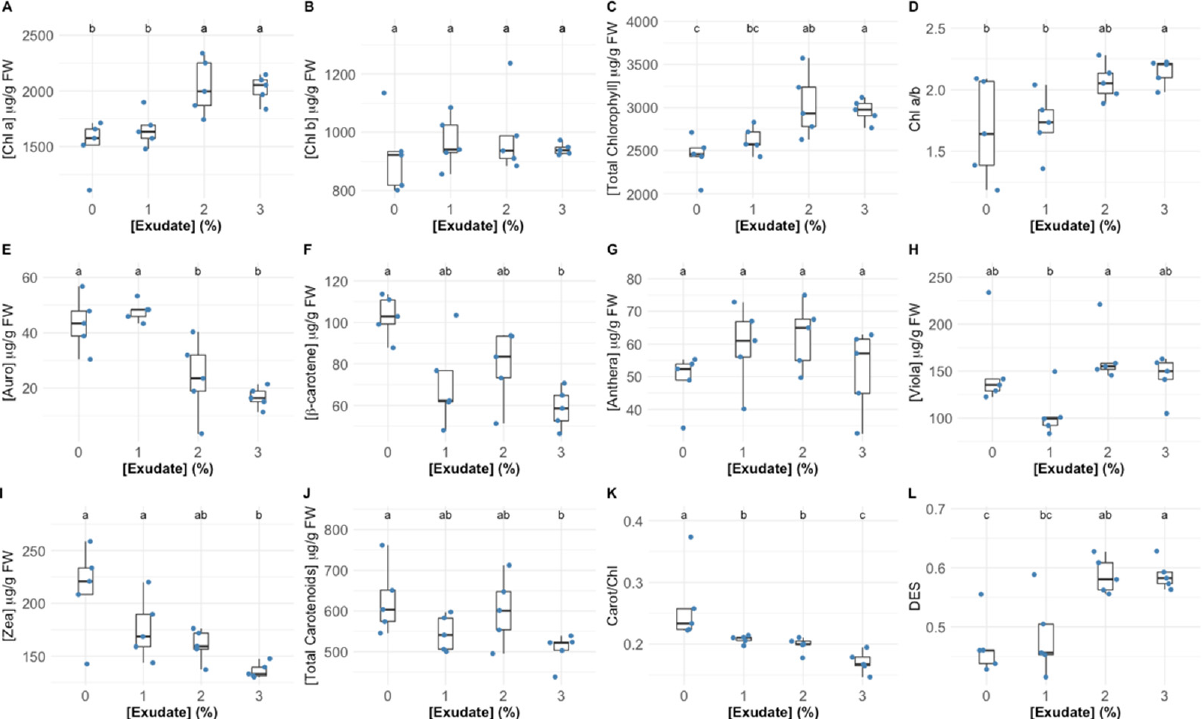
Figure 4. Thellungiella halophila pigment concentrations (Chl a—chlorophyll a ( A ); Chl b—chlorophyll b ( B ); Total chlorophyll ( C ); Auro—auroxanthin ( E ); β -carotene ( F ); Anthera—antheraxanthin ( G ); Viola—violaxanthin ( H ); Zea—zeaxanthin ( I )), classes (total carotenoids ( J )) and ratios (Chl a/b—chlorophyll a to chlorophyll b ratio ( D ); Carot/Chl—total carotenoid total to chlorophyll ratio ( K ); DES—De-Epoxidation State ( L )) in leaves exposed to Asparagopsis armata exudate at the proposed target concentrations at the end of the trial period, (N = 5 per treatment; letters denote significant differences between treatments at p <